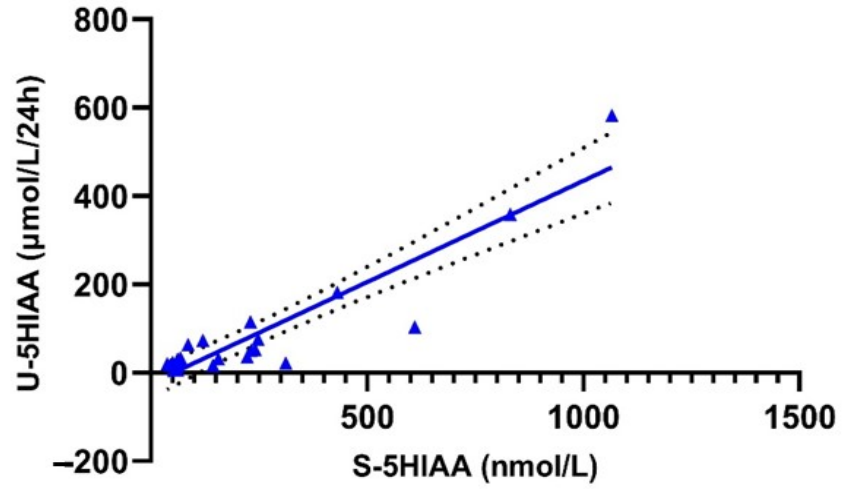
Figure 4. XY plot of urinary and serum 5HIAA values demonstrating a strong linear correlation (Spearman’s correlation test, r = 0.792, p <